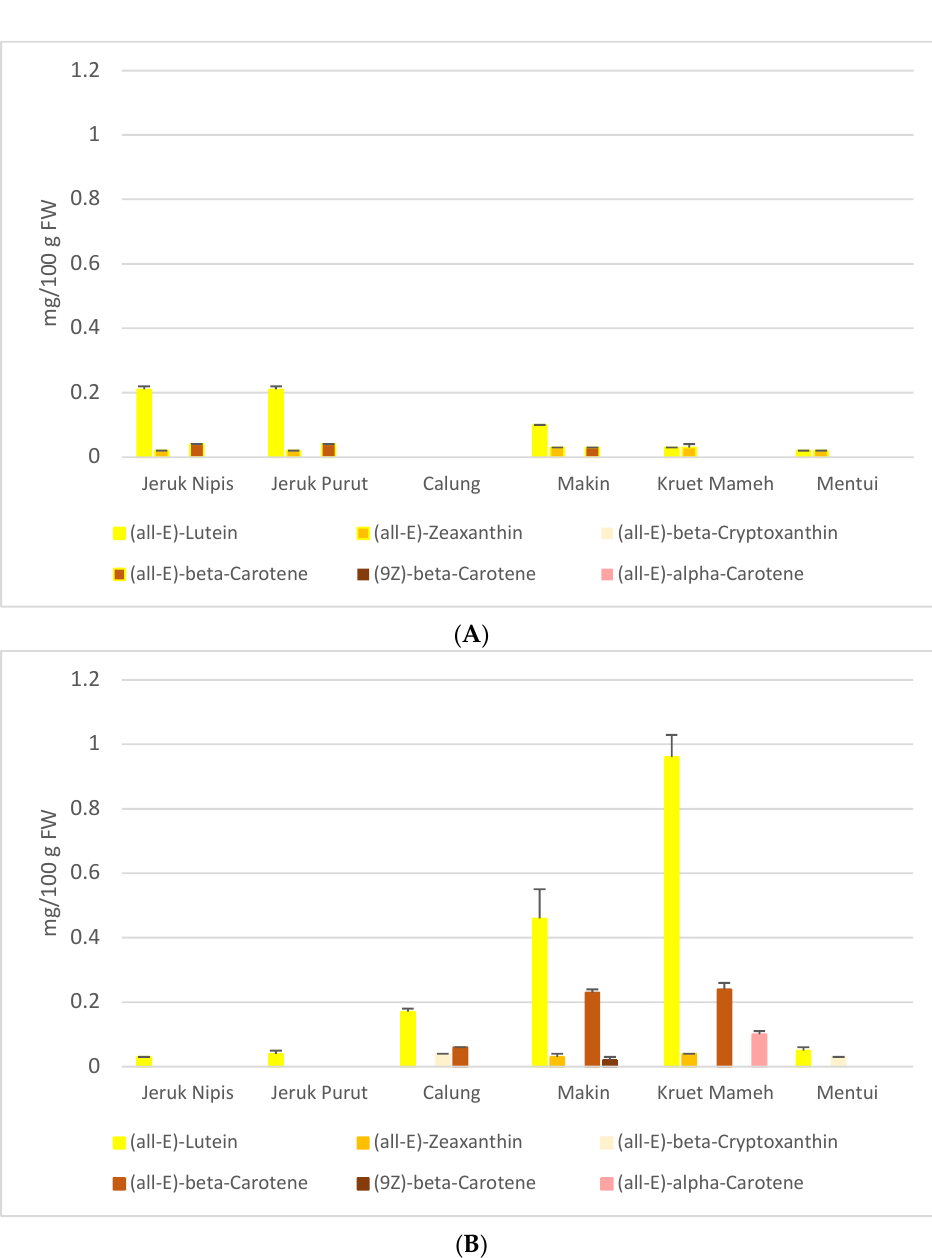
Figure 1. Carotenoid composition of peel ( A ) and pulp ( B ) of citrus fruits from Aceh (adapted from Ernawita et al., 2016 [19])